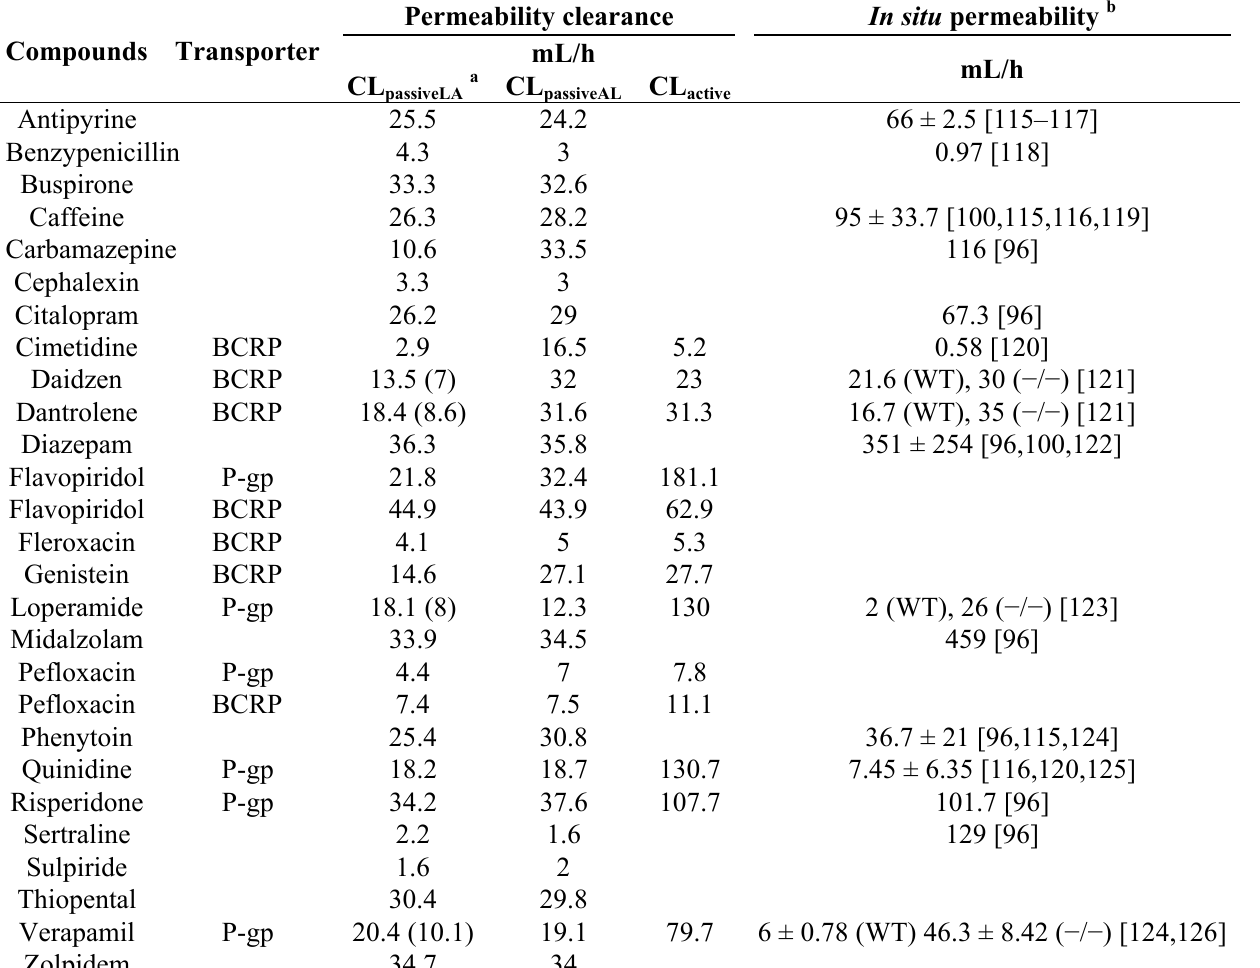
Table S6. Model predicted versus literature reported in situ